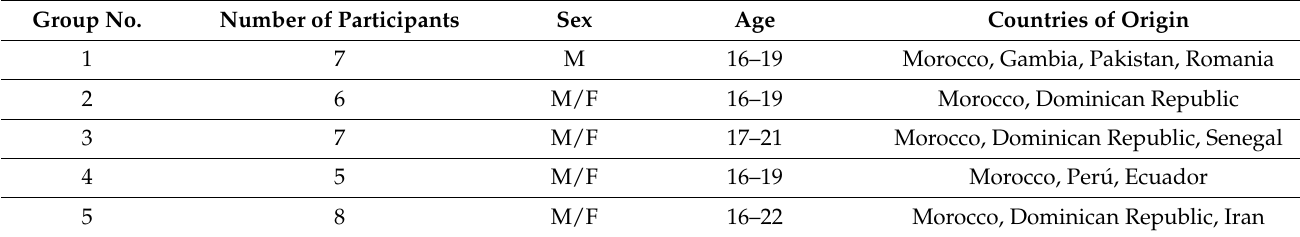
Table 2. Focus Groups